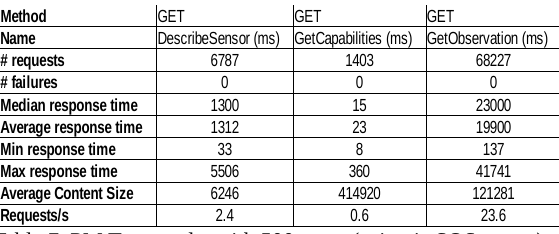
Table 7. PM Test results with 500 users (using